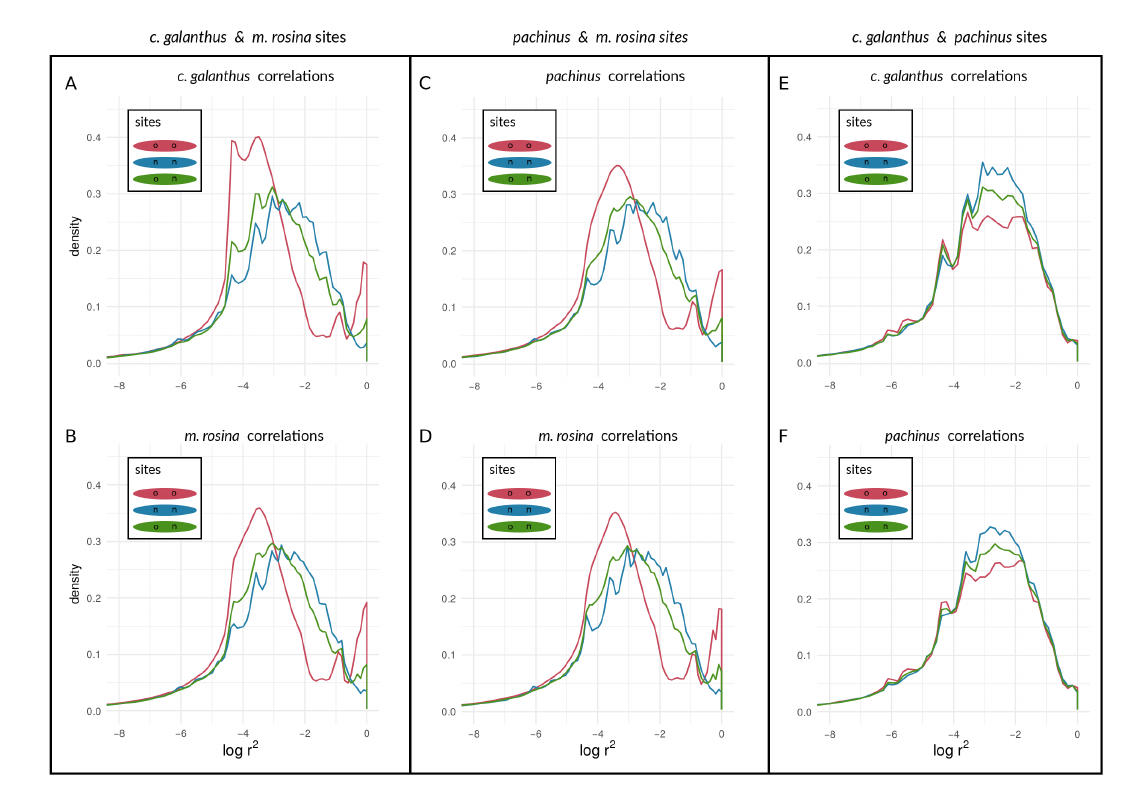
Figure 7. Density curves of within-species LD for loci at different types of sites on Chromosome 2, determined by F ST outliers. Log r 2 values are shown between outlier loci, between non-outliers, and between outliers and non-outliers for species pairs of H. cydno galanthus and H. melpomene rosina ( A , B ), of H. pachinus and H. melpomene rosina ( C , D ), and of H. cydno galanthus and H. pachinus ( E , F